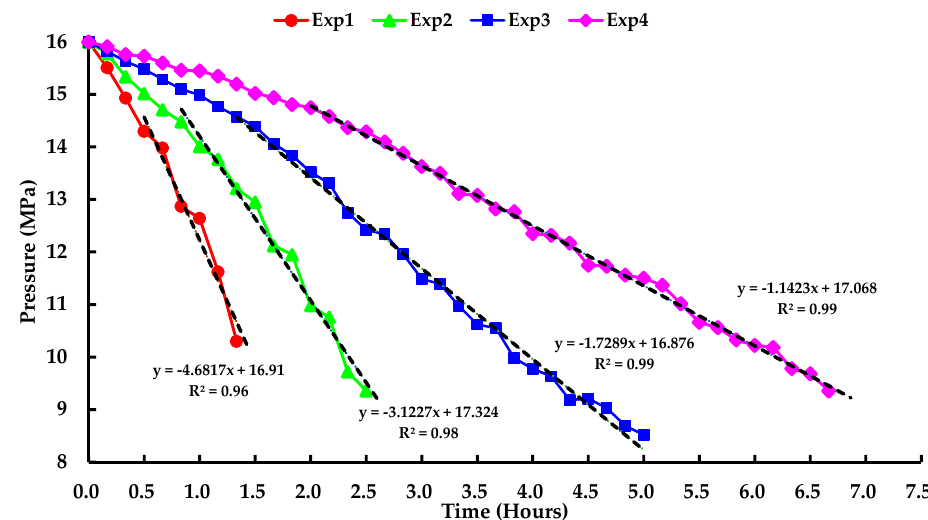
Figure 10. The model pressure of different experiments during the production process.